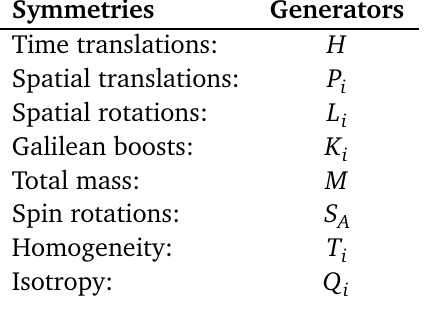
Table 1: Relevant symmetries of lattice of spins in three spatial dimensions in the continuum limit. Some of these symmetries may be spontaneously and / or explicitly broken